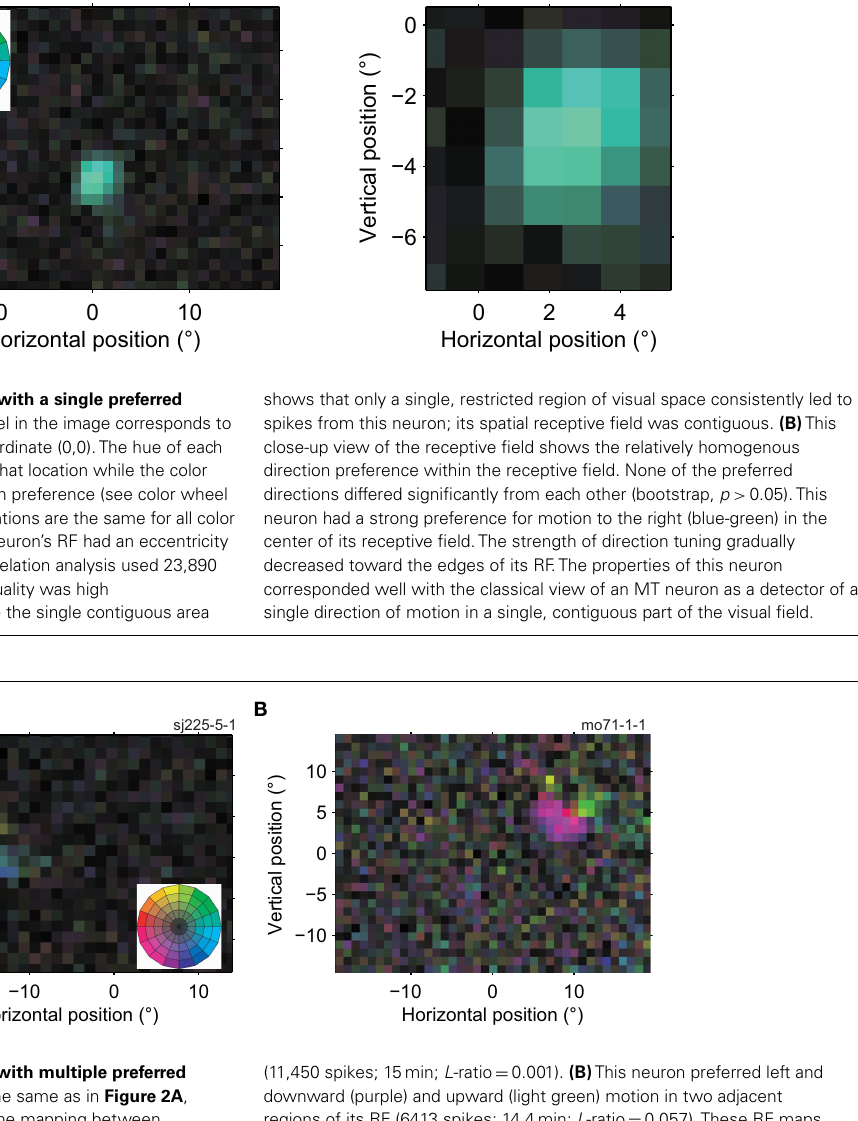
FIGURE 3 | Receptive fields of two MT cells with multiple preferred directions. The conventions in this figure are the same as in Figure 2A , the color wheel inset serves as a reminder of the mapping between direction and color (see Figure 1F ). (A) This neuron preferred upward (yellow) and rightward (blue) motion in two adjacent regions of its RF